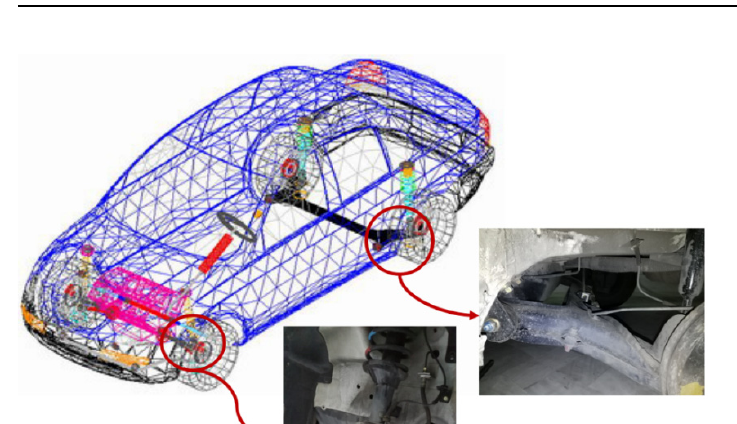
Table 4. Values of suspension system parameters.